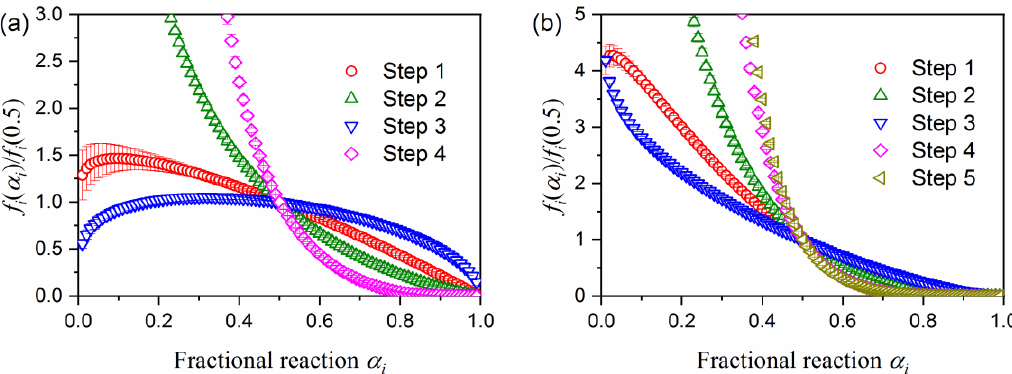
Figure 8. Rate behaviors for each reaction step of the thermal decomposition of ( a ) palygorskite and ( b ) sepiolite, reproduced from SB ( m i , n i , p i ) optimized by KDA.